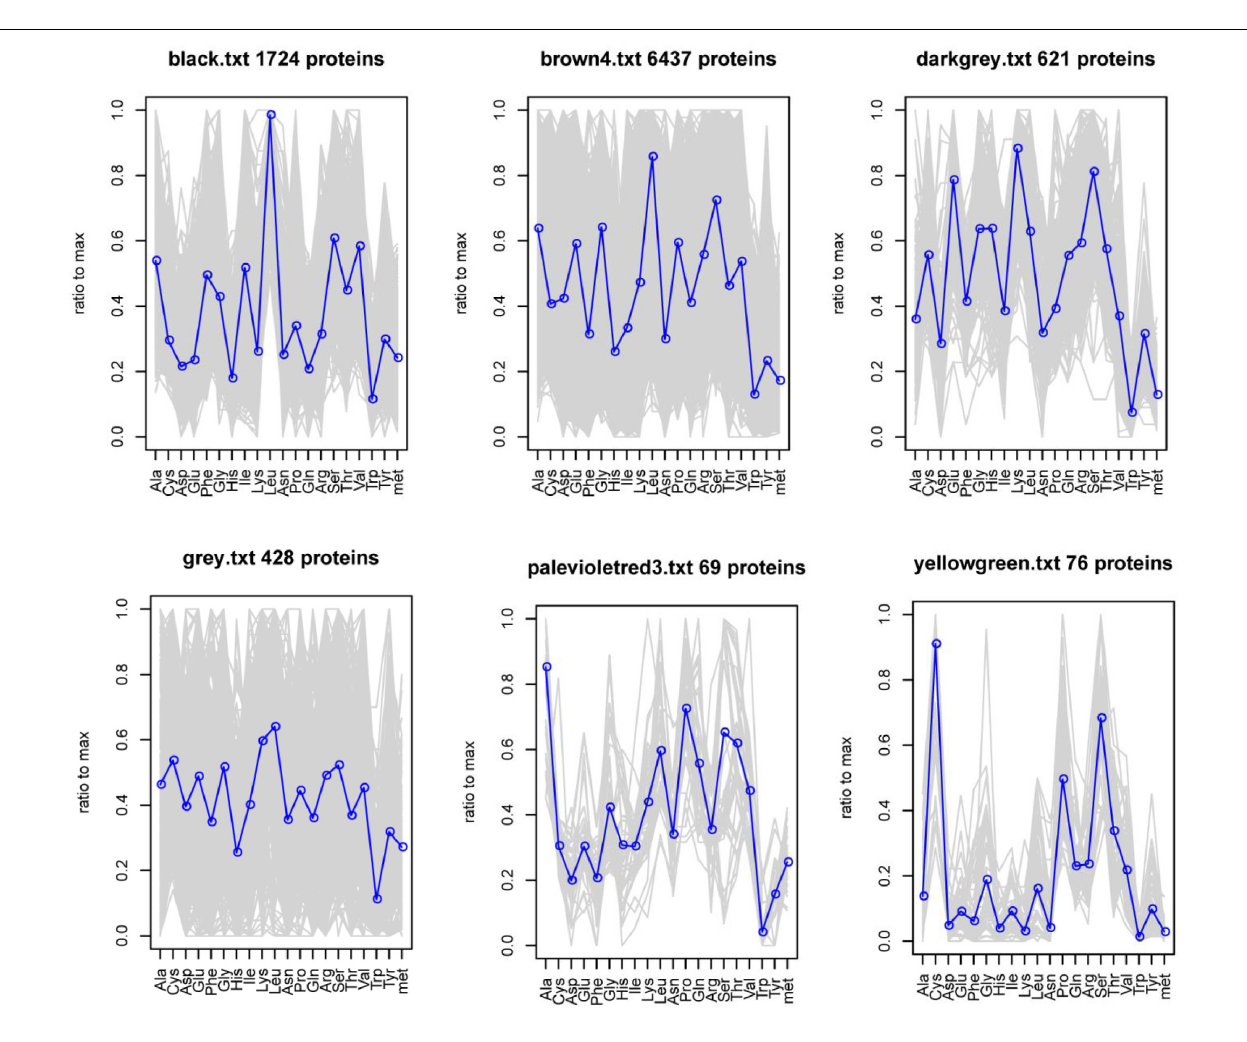
FIGURE 6 | Abundance of 20 amino acids in each CDS in the